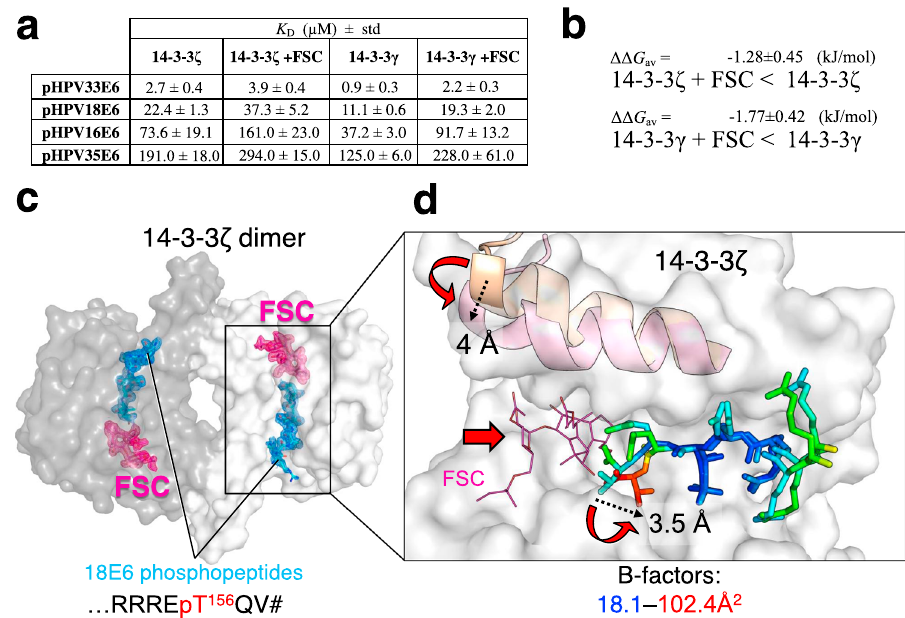
Fig. 3 The 14-3-3 ζ /18E6 PBM interaction is druggable by FSC. a Af fi nities of four selected HPV E6 phospho-PBMs toward human 14-3-3 ζ and 14-3-3 γ in the absence and presence of FSC as determined by FP using FITC-labeled HSPB6 phosphopeptide as a tracer. Protein names are boldfaced for clarity. Apparent K D values determined from competitive FP experiments are presented. Standard deviation (std) values are indicated. The binding curves are shown in Supplementary Fig. 2. b Averaged ΔΔ G values between 14-3-3 – E6 phospho-PBM pairs in the absence or presence of FSC, calculated based on their observed order of binding af fi nities (from weakest to strongest). Individual K D values from Supplementary Fig. 2 were fi rst converted into Δ G values (at T = 295 K; excluding cases when K D > 300 μ M), then average ΔΔ G values ( ΔΔ G av ) were calculated for the E6-binding af fi nity changes of the indicated 14-3-3 isoforms in the absence or presence of FSC. c An overall view on the ternary complex between 14-3-3 ζ (subunits are shown by surface using two tints of gray), 18E6 phosphopeptide (cyan sticks), and FSC (pink sticks). FSC was soaked into the 14-3-3 ζ – 18E6 chimera crystals. 2F o -F c electron density maps contoured at 1 σ are shown for the phosphopeptide and FSC only. d The effect of FSC binding. Conformational changes in the 9th α -helix of 14-3-3 and in the C-terminal part of the 18E6 phosphopeptide upon FSC binding are shown by red arrows, a signi fi cant rise of the local B-factors of the phosphopeptide is shown using a gradient from blue to red as indicated. The amplitudes of the conformational changes are indicated in Å by dashed arrows.